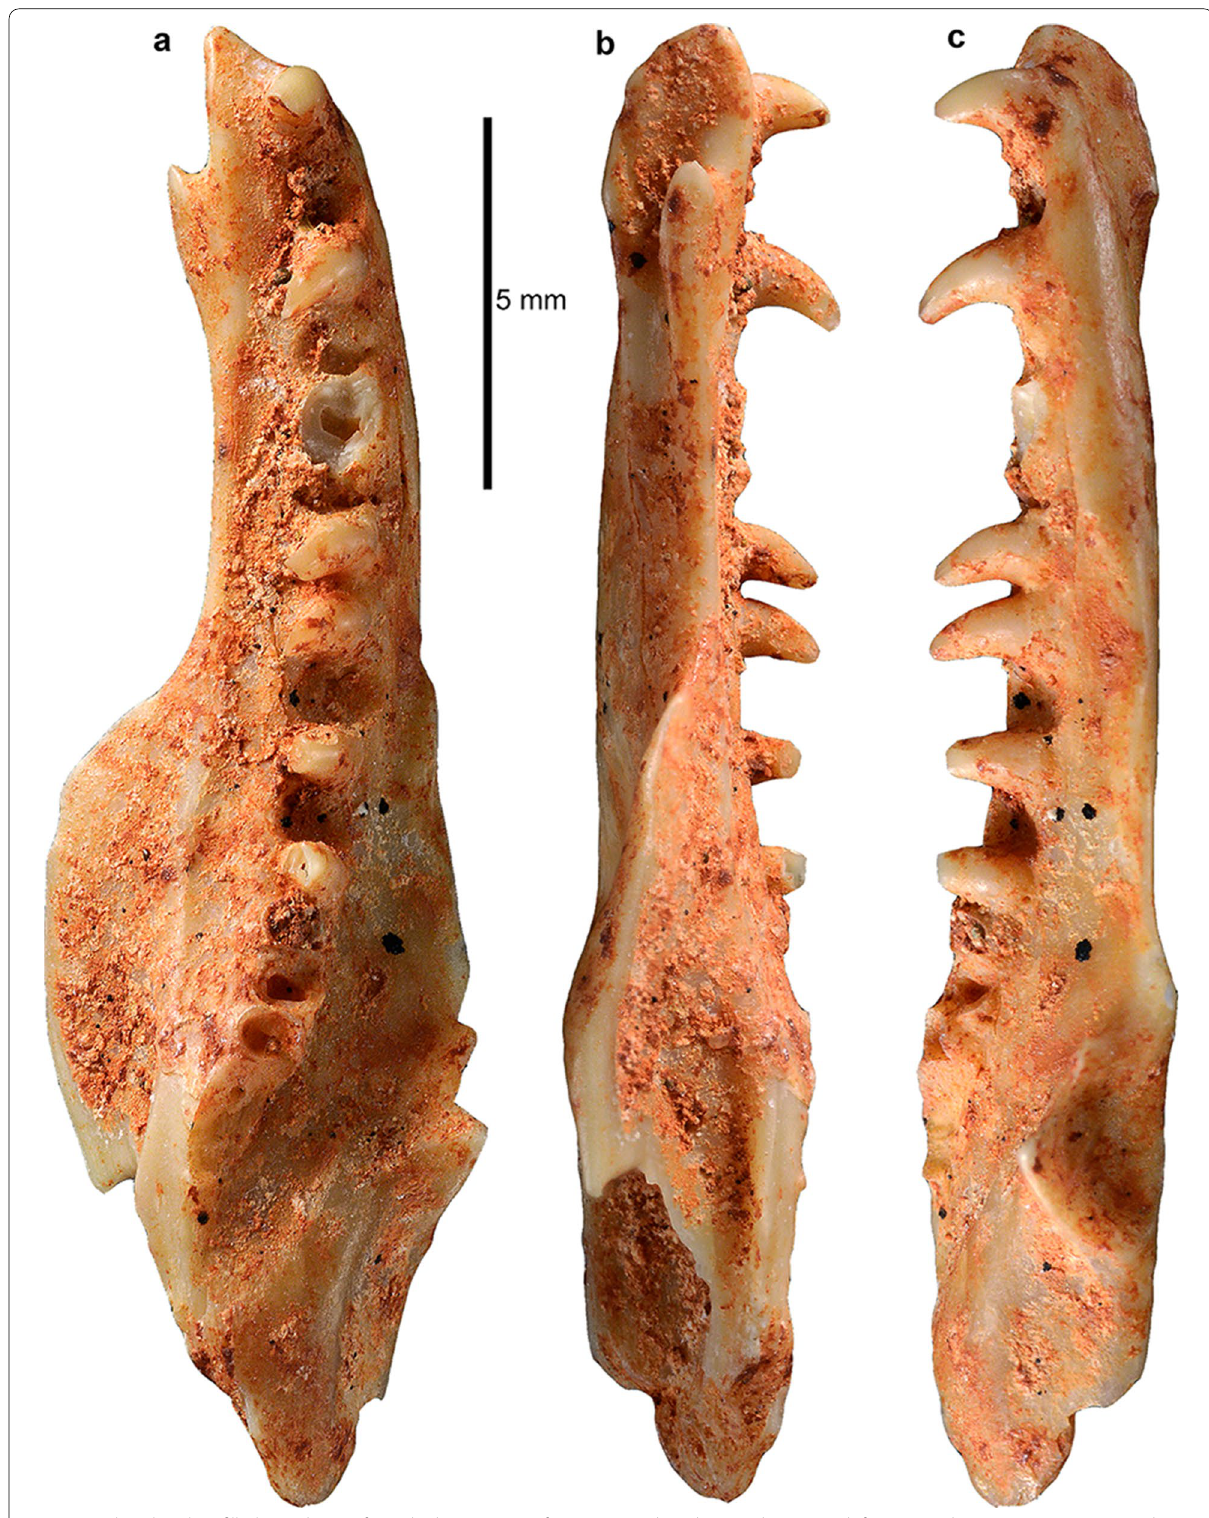
Fig. 101 Phosphoroboa filholii comb. nov. from the late Eocene of Escamps C, Phosphorites du Quercy: left pterygoid (UM ECC 2501) in ventral ( a ), medial ( b ), and ventrolabial ( c ) views. A drawing of this specimen was originally figured by Rage (1974:fig.